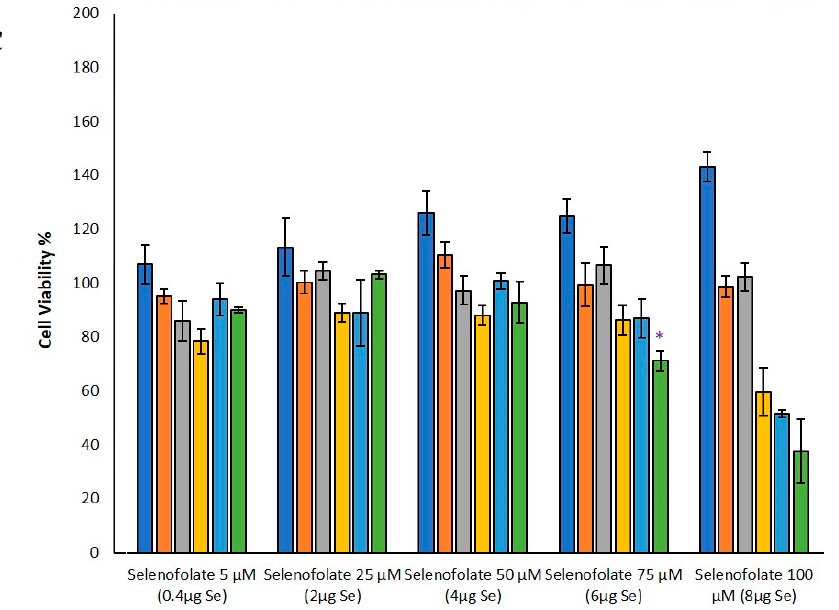
Figure 7. Analysis of metabolic activity as a function of percent cell viability during treatment of MDA-MB-468cells. E ff ectsonmetabolicactivityin( a )controlandselenite, ( b )FolicAcid, ( c )Selenofolate treatments against MDA-MB-468 cells as determined by the MTT assay. Forty-thousand cells were treated as shown (Day 0 = start of treatment) with 5 µ M, 25 µ M, 50 µ M, 75 µ M and 100 µ M Folic acid and Selenofolate with Se equivalents of 0.4 µ g, 2 µ g, 4 µ g, 6 µ g, and 8 µ g respectively. The data represent the mean ± SE ( n = 3). Treatments were compared using two sample t-tests and treatments that were statistically significant at p ≤ 0.05 (indicated by *) are summarized in Table 1. Table 1. Statistical analyses of the e ff ects of Folic acid and Selenofolate treatments on MDA-MB-468 cells.